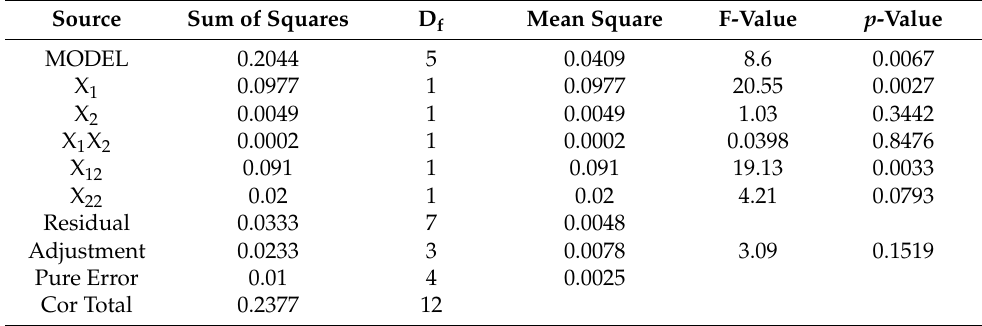
Table 3. ANOVA results for the quadratic polynomial model response